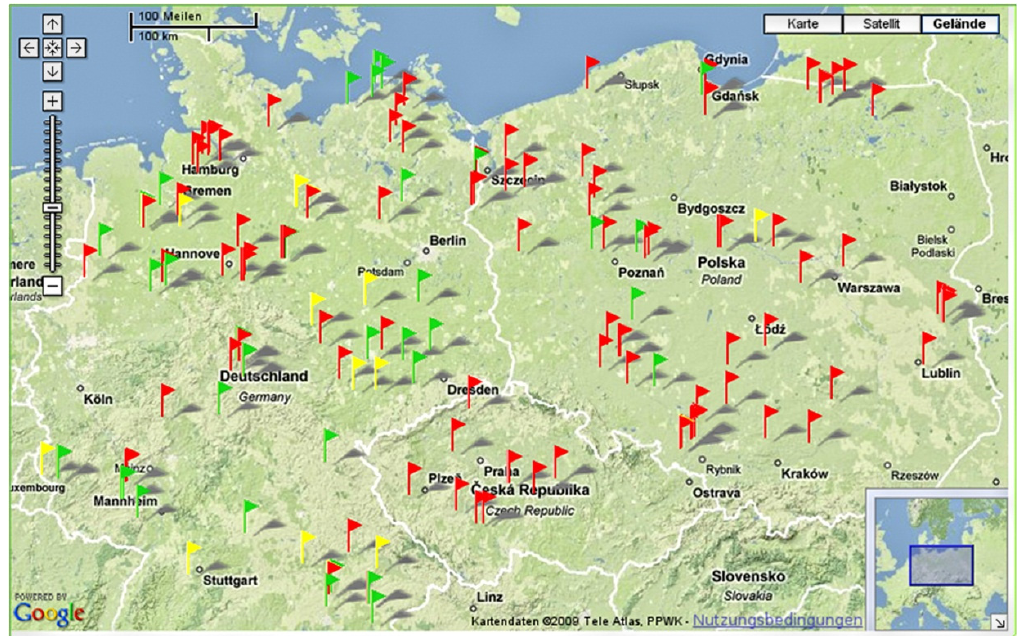
Figure 3. Screenshot example (terrain view) of the geographic information system (GIS) database “Weedscout” [30] showing the distribution of A. spica-venti populations in Germany, Poland and the Czech Republic. Cases of verified resistance are identified by the red flags, cases of unverified resistance by the green flags and cases of suspected resistance by the yellow